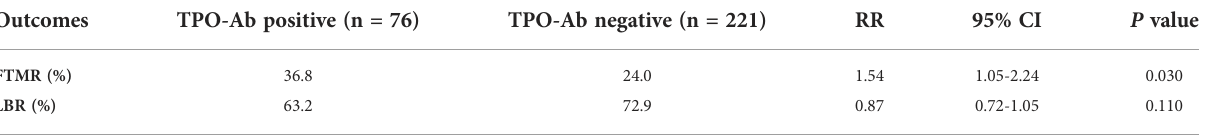
TABLE 2 FTMR and LBR in euthyroid women with